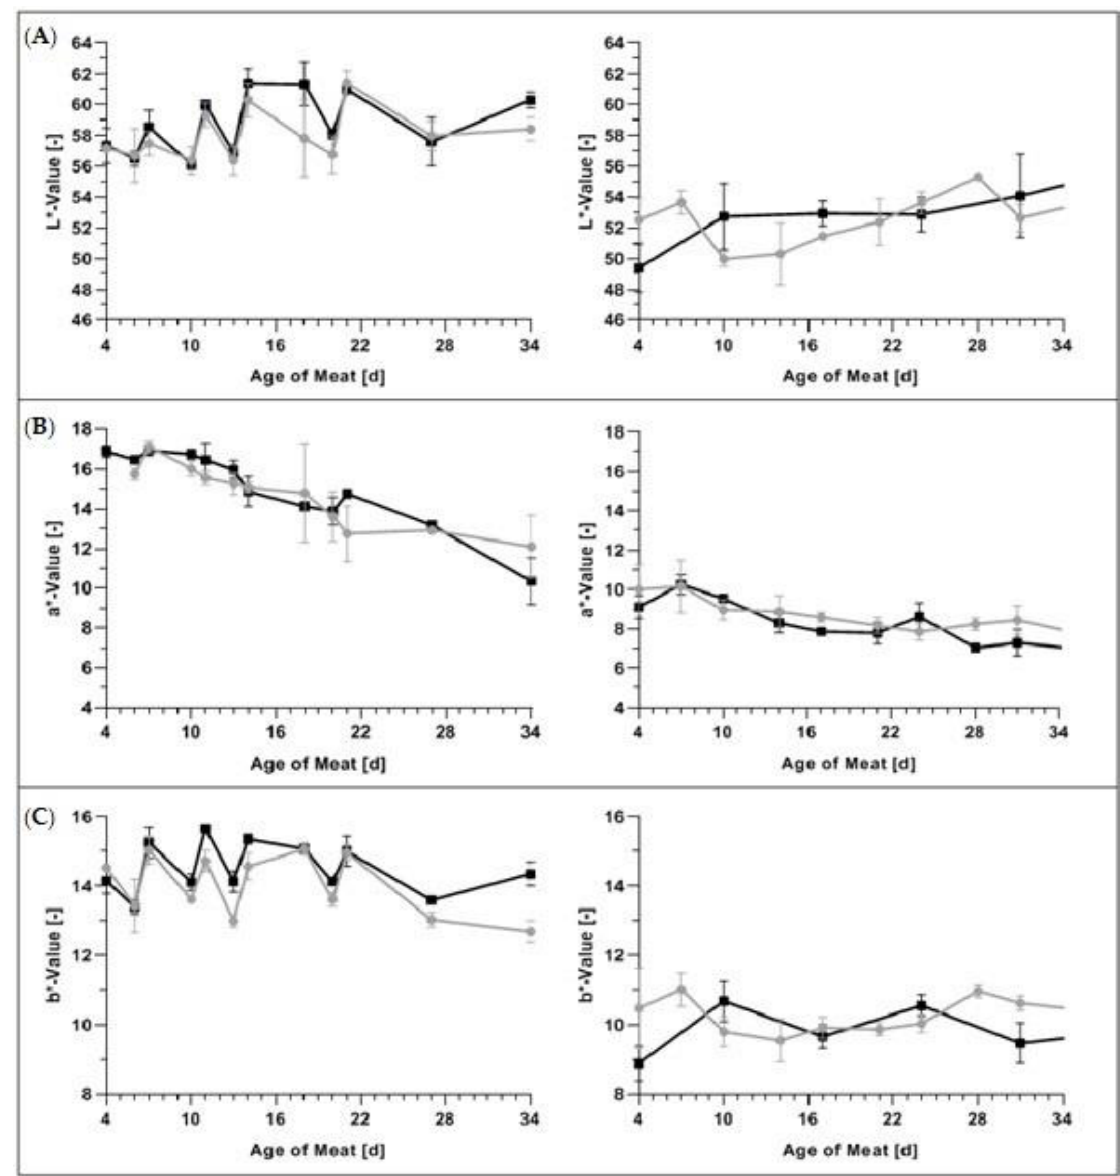
Figure 6. Average ( A ) L*-values (±S.D.); ( B ) a*-values (±S.D.); and ( C ) b*-values (±S.D.) in Figure 6. Average ( A ) L*-values ( ± S.D.); ( B ) a*-values ( ± S.D.); and ( C ) b*-values ( ± S.D.) in Figure A2. Average TBCs (±S.D.) in BioMAP and MAP in ( A ) ground pork (GM) and Figure A2. Average TBCs (±S.D.) in BioMAP and MAP in ( A ) ground pork (GM) and ( B ) pork loin (PL) over a meat age of 34 and 52 days, respectively. Microbiological limits “m” and BioMAP and MAP in left-hand GM and right-hand PL over a meat age of 34 days. MAP in left-hand GM and right-hand PL over a meat age of 34 ( B ) pork loin (PL) over a meat age of 34 and 52 days, respectively. Microbiological limits “m” and “M” as per European Union legislation are indicated for both meat matrices. The fitted curves are “M” as per European Union legislation are indicated for both meat matrices. The fitted curves are indicated by dotted lines for GM and PL in BioMAP and MAP, respectively, with slope values indicated by dotted lines for GM and PL in BioMAP and MAP, respectively, with slope values included in the graphs. included in the graphs.